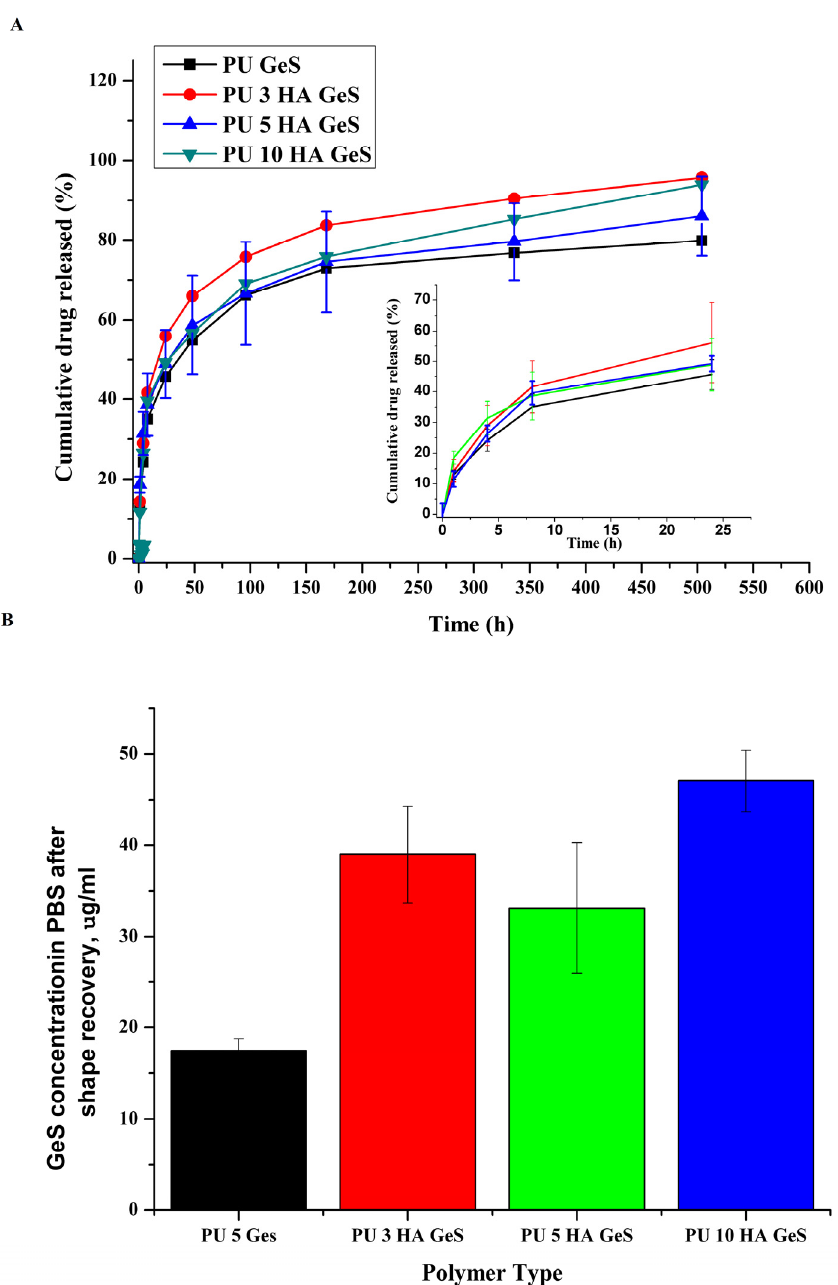
Figure 7. ( A ) Gentamicin-sulfate-release kinetics from PU/HA/GeS; ( B ) GeS concentration in water after shape recovery. Table 3. The correlation coefficient R 2 from in-vitro-release data of GeS for different release-kinetic models.